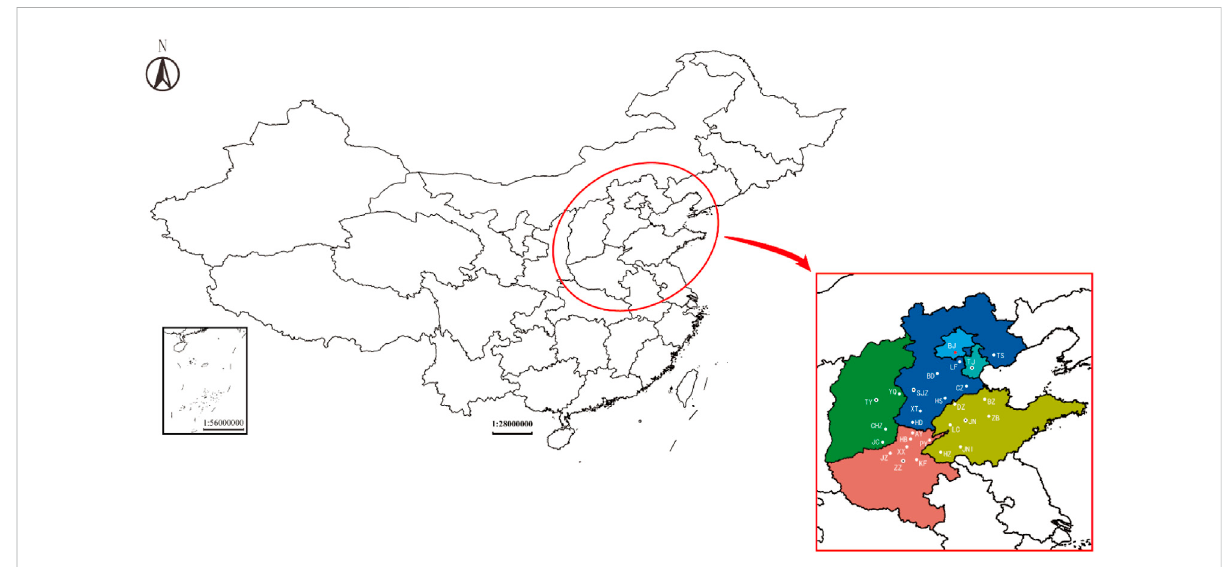
FIGURE 1 The Beijing-Tianjin-Hebei Air Pollution Transmission Channel ( “ 2+26 ”